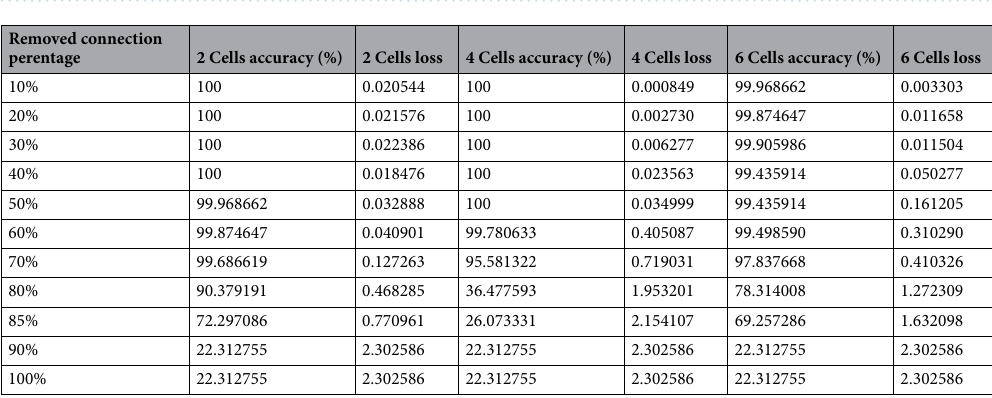
Table 11. Model pruning percentage and accuracy comparison.